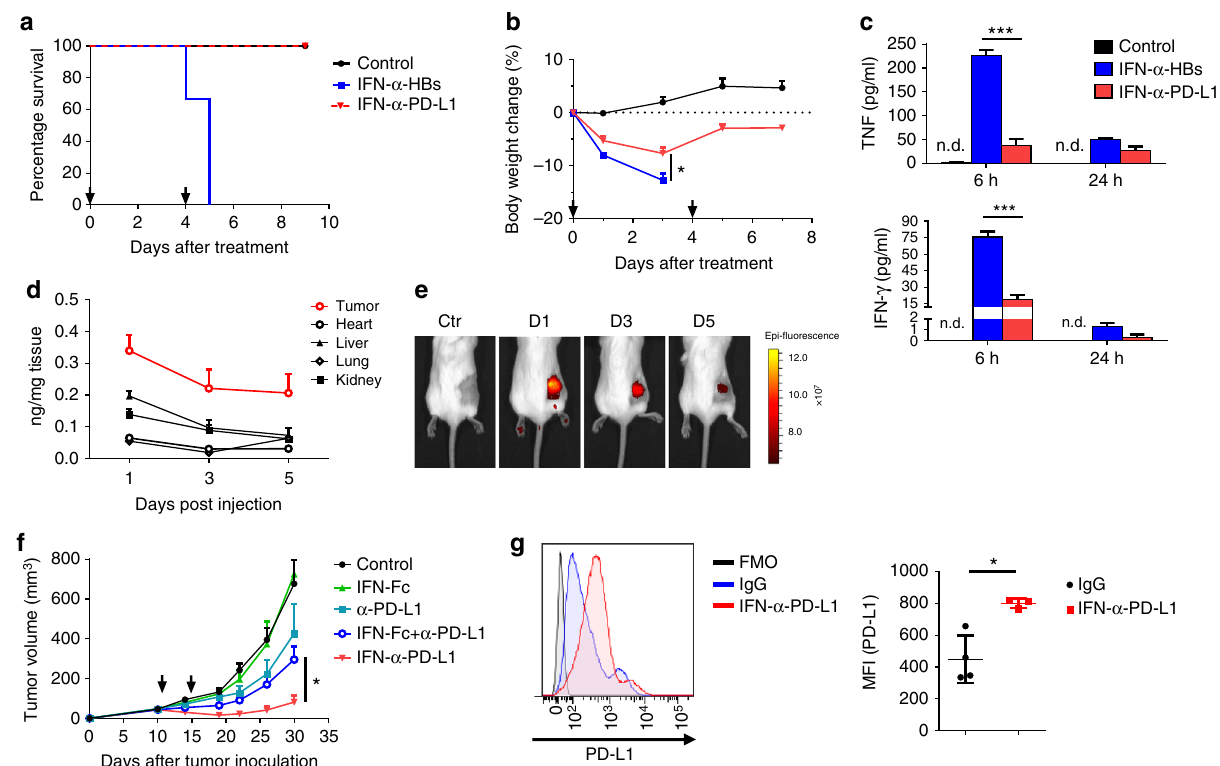
Fig. 3 IFN α -armed anti-PD-L1 leads to maximal antitumor activities with minimal toxicities. a , b MC38 tumor-bearing mice were injected i.v. with 100 μ g IFN α -anti-PD-L1 heterodimer or IFN α -anti-HBs protein on day 0 and 4. The mice survival curves ( a ) and body weight changes ( b ) were shown. c MC38 tumor-bearing mice were injected i.v. with 100 μ g IFN α -anti-PD-L1 or IFN α -anti-HBs protein. Serum was collected at 6 or 24 h after injection. Cytokine levels in the serum were measured by cytometric bead array (CBA). d MC38 tumor-bearing mice were injected i.v. with 30 µ g of IFN α -anti-PD-L1. Tissues were collected on days 1, 3, and 5 after injection. Concentrations of fusion protein were measured by ELISA. e IFN α -anti-PD-L1 protein was conjugated with Cy5.5-maleimide. 25 μ g of CY5.5- IFN α -anti-PD-L1 protein was injected into A20 tumor-bearing mice. The protein accumulating within tumor was tracked by IVIS spectrum in vivo imaging system. f A20 tumor-bearing mice ( n = 5) were treated i.v. with IFN α -Fc (12.5 μ g), anti-PD-L1 (12.5 μ g), a mixture of IFN α -Fc and anti-PD-L1 (12.5 μ g + 12.5 μ g), or IFN α -anti-PD-L1 fusion protein (25 μ g) on days 11 and 15. Tumor size was measured twice a week. g MC38 tumor-bearing mice were treated with 25 µ g control Ig or IFN α -anti-PD-L1. Two days later, tumor tissues were harvested and PD-L1 levels were determined by fl ow cytometry. A representative graph is shown on the left, and MFI is shown on the right. FMO fl uorescence minus one. Data indicate mean ± SEM and are representative of at least two independent experiments. * p < 0.05; ** p < 0.01; *** p < 0.001; n.d. not detectable, n.s. not signi fi (Fig. 5e). Both IFN α -Fc and IFN α -anti-PD-L1 fusion proteins could cells is suf fi cient for both the tumor-targeting and antitumor indeed activate murine CD8 + T cells ef fi ciently in vitro (Supple- effects of IFN α -anti-PD-L1.